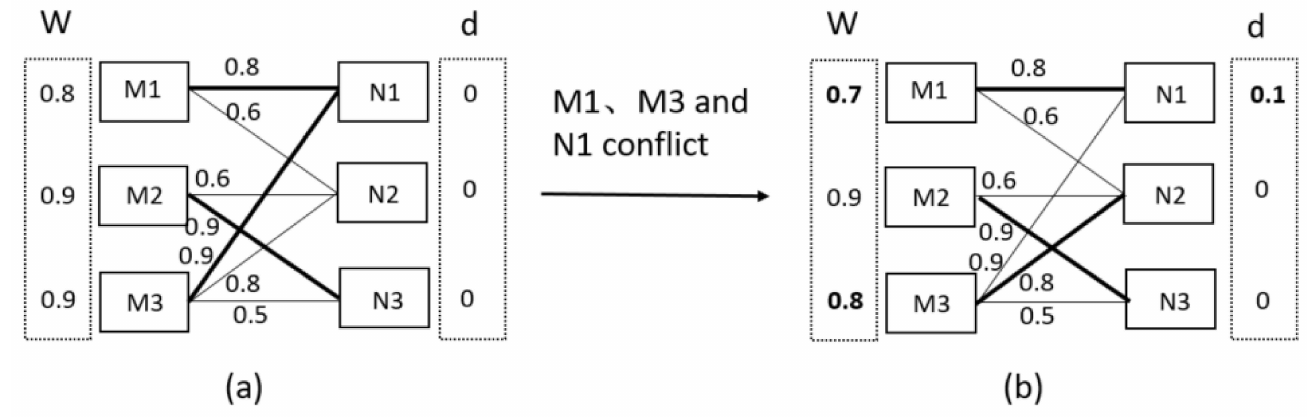
Figure 12. Schematic diagram of KM algorithm. ( a ) Initialize W, d. ( b ) Resolve